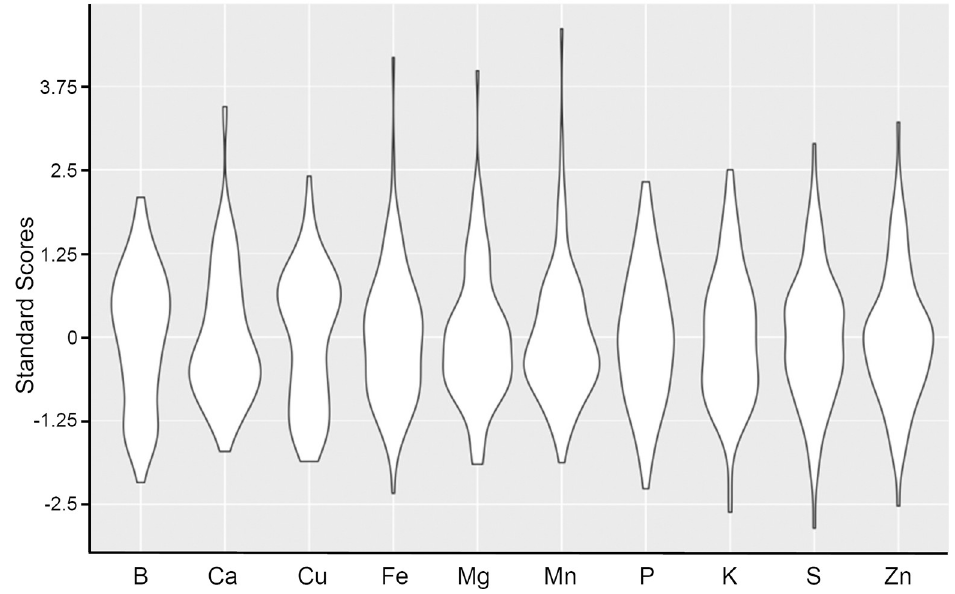
Fig 1. Violin plots displaying the distribution of standard scores for concentration of each element.